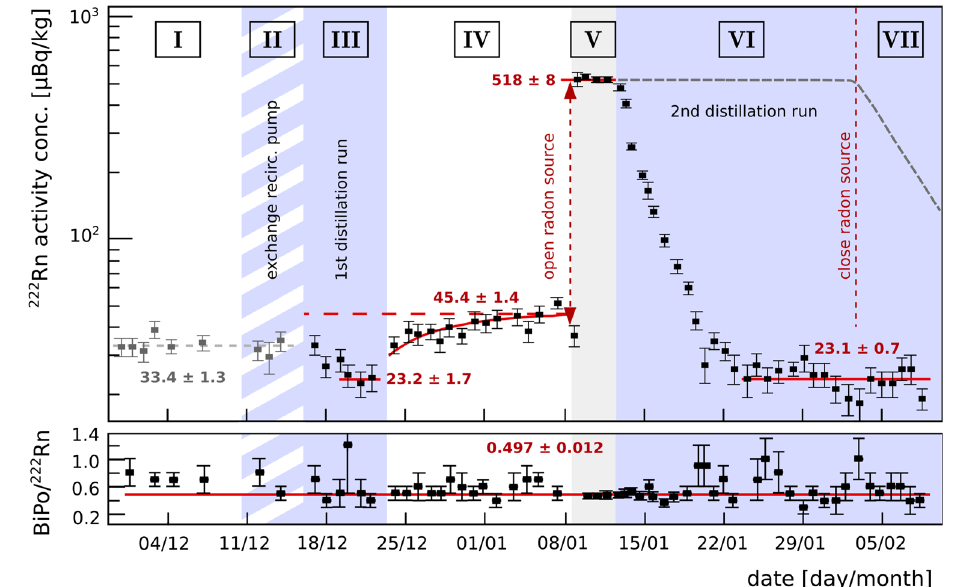
Fig. 4 Top panel Evolution of the 222 Rn activity concentration in XENON100 during the radon distillation campaign. The seven differ- ent phases ( roman numerals ) show different operational modes of the